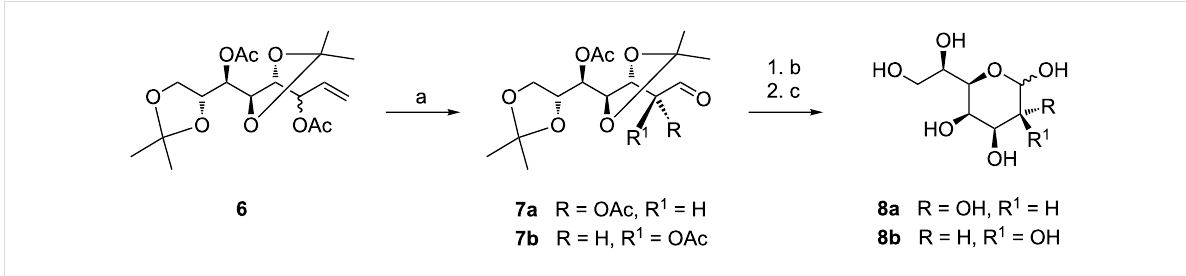
Scheme 2: Synthesis of D- glycero -D- galacto /D- talo -heptopyranose 8a and 8b : a) O 3 , NaOAc, Me 2 S, CH 2 Cl 2 /MeOH, − 50 °C, b) NaOMe, MeOH; c) ion exchange resin IR 120 H + , H 2 O/MeCN.